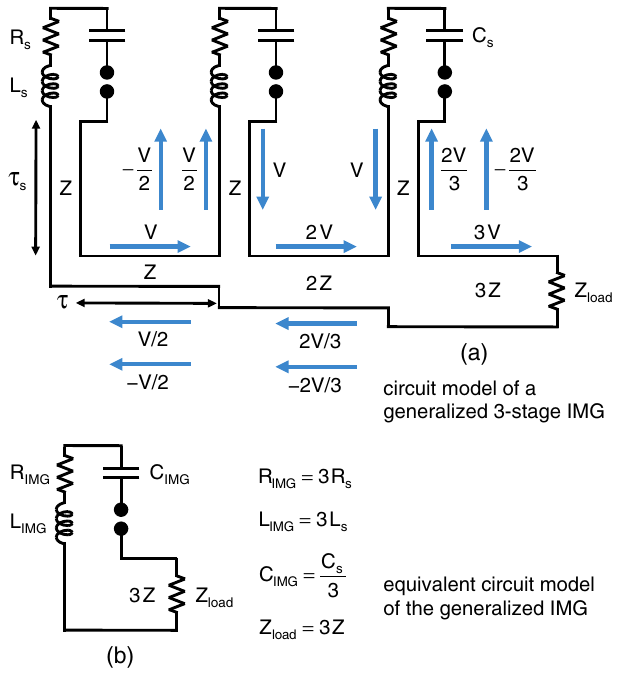
FIG. 14. (a) Circuit model of a generalized three-stage imped- is the ance-matched Marx generator (IMG). The quantity R s is the effective series resistance of a single IMG stage; L s is the series stage capaci- effective series stage inductance; C s tance; Z is the impedance of each of the vertical transmission-line segments driven by the IMG, as well as that of the first horizontal is the one-way electromagnetic transit time of a segment; τ s vertical segment; τ is the one-way electromagnetic transit time of a horizontal segment; and V is the time-dependent forward-going voltage that is launched by each stage. (b) When each stage is triggered at time τ after the stage immediately upstream is triggered, the circuit of (a) can be simplified as that given by is the effective series resistance of (b). The quantity R IMG is the effective series IMG inductance, C is the IMG, L IMG IMG is the load impedance. The the series IMG capacitance, and Z load figure makes clear that all the reflected and backward voltages within a generalized multistage IMG